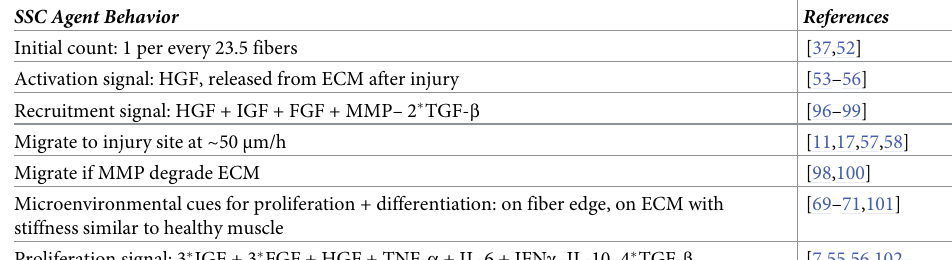
Table 2. SSC agent behaviors were defined by literature derived rules. SSC Agent